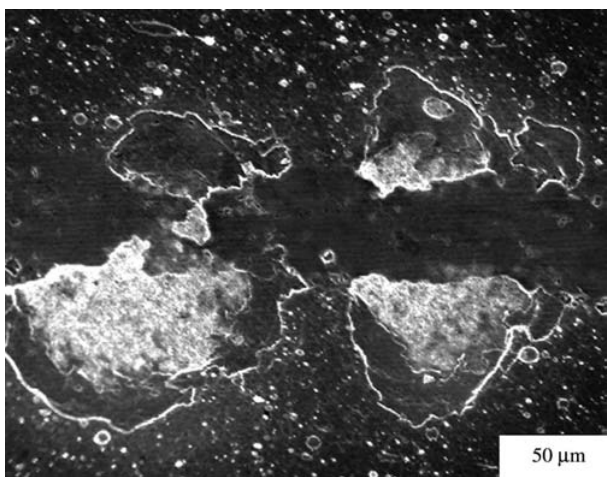
Figure 5. Defects characteristic of the TiN/ (Ti,Al,Si)N/TiN coating surfaceDefects characteristic of the TiN/ (Ti,Al,Si)N/TiN coating surface deposited onto the W2 type cemented carbide.